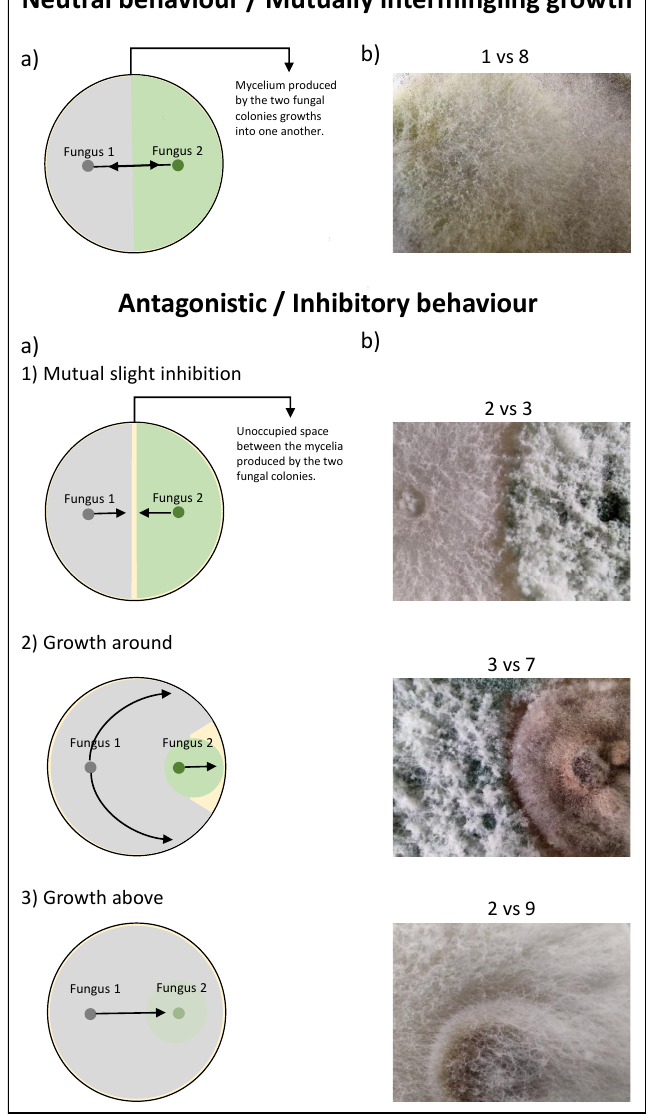
Figure 3. ( a ) A simplified schematic illustration of the interaction between fungi at the interface during dual nucleation assay. Arrows indicate the growth of the new-born mycelium produced by fungus 1 (i.e., Trichoderma strains) and fungus 2, and circles indicate the initial mycelial plugs, which served as inoculum (see Materials and Methods section for more details). ( b ) Pictures at the interface of the dual nucleation dynamic assay of different fungi reported in Table 2, i.e., Trichoderma simmonsii EXF-17015 (No. 1), Trichoderma sp. EXF-17016 (No. 2), Trichoderma sp. EXF-17020 (No. 3), Fusarium ramigenum EXF-17018 (No. 7), Rhizopus arrhizus EXF-17019 (No. 8), and Botrytis caroliniana EXF-17025 (No. 9) (Magnification: 5X). Fungal cultures were performed on a PDA medium, as reported in the Materials and Methods section. Pictures were taken up to 144 h